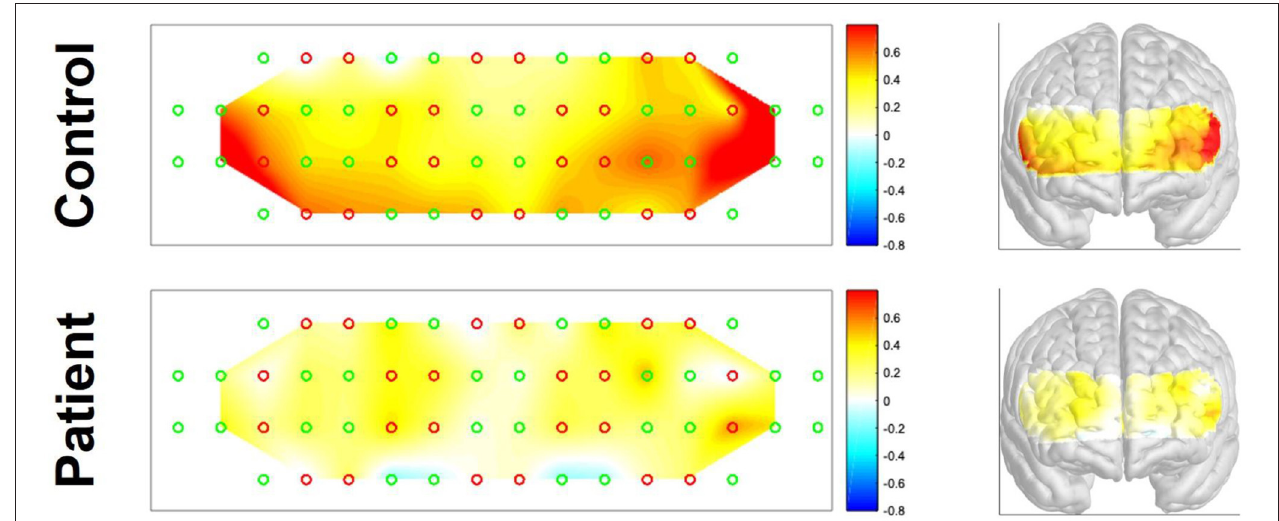
FIGURE 2 | Activation maps of the two groups during the verbal fluency task.